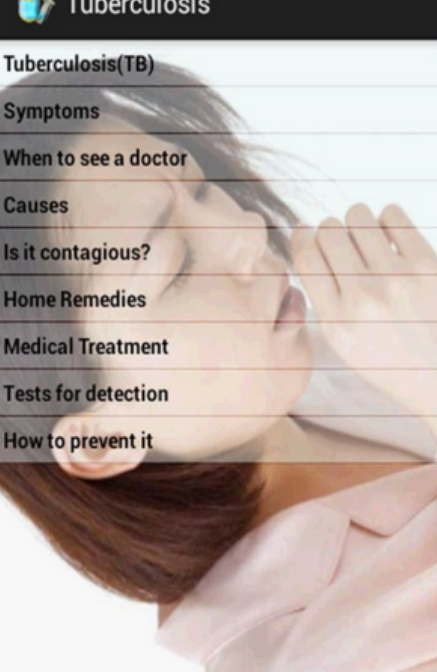
Figure 5. Tuberculosis (Amazon). Home